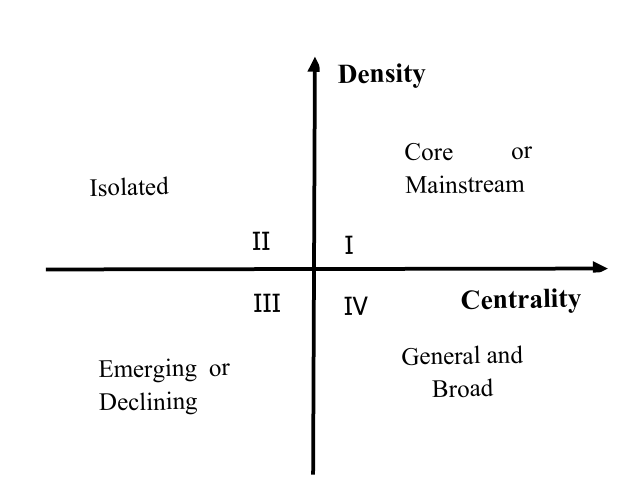
Fig. 1. Strategic diagram characterizations based on density and centrality